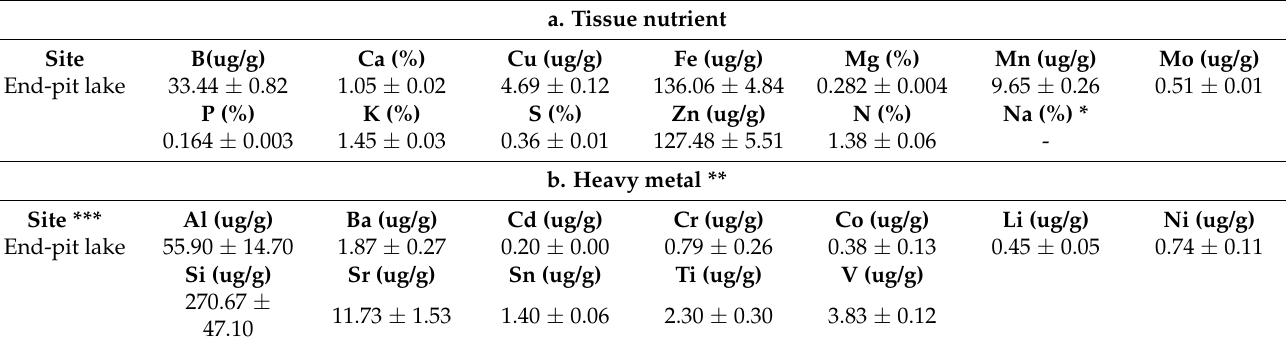
Table 5. Mean tissue nutrient (a) and heavy metal (b) analysis ( ± SE) based on leaf tissue samples in two-year-old balsam poplar trees.